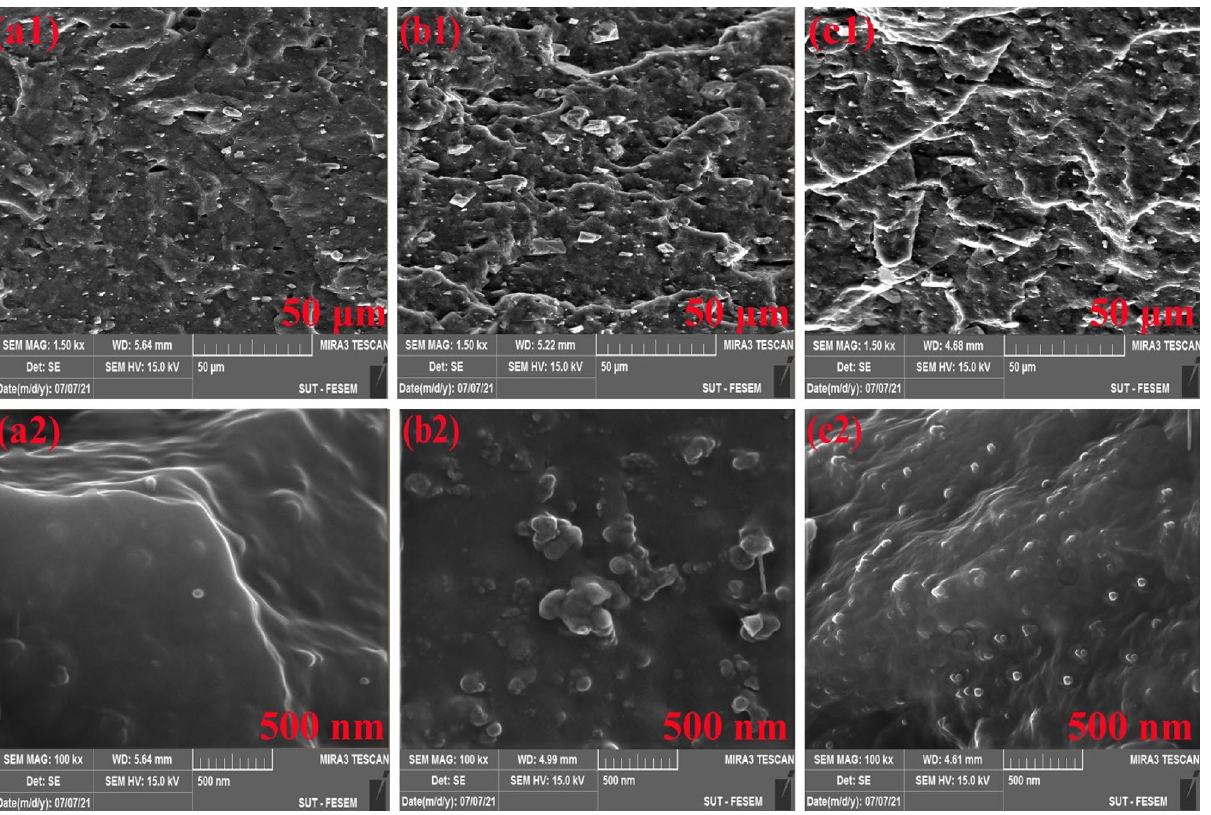
Figure 9. FE-SEM micrographs of NBR based samples; ( a1 , a2 ) R-ctrl, ( b1 , b2 ) R-NP and ( c1 , c2 )